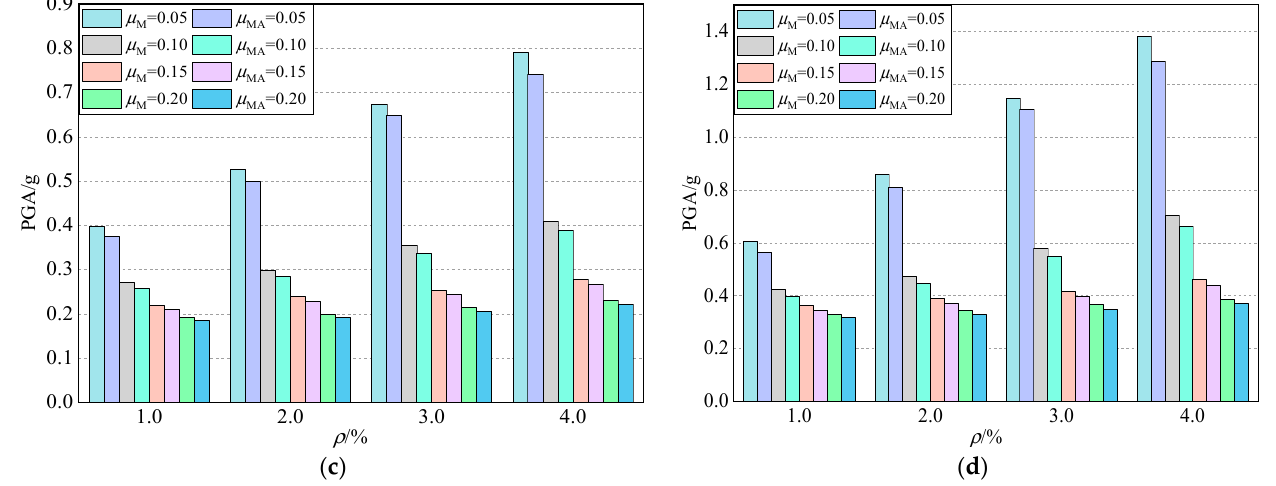
Figure 11. The median fragility PGA 50% beyond different damage states: ( a ) minor damage; ( b ) medium damage; ( c ) severe damage; ( d ) complete failure.